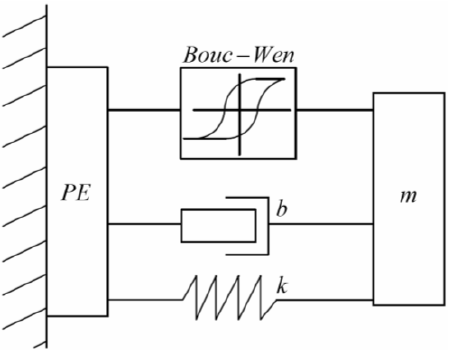
Figure 3. The equivalent illustration of a piezoelectric-based micro-positioning actuator.